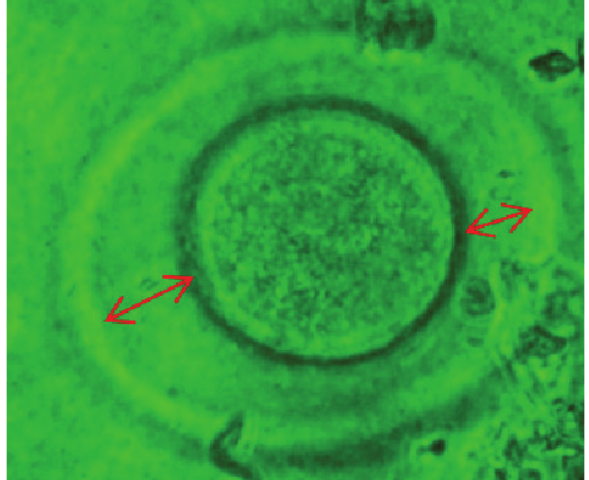
) sem clivagem Figura 5. Embrião exposto aos vírus e ao extrato etanólico da 2 casca de Punica granatum _(Grupo G Com três clivagens e oito células (100x, 5,7x zoom).